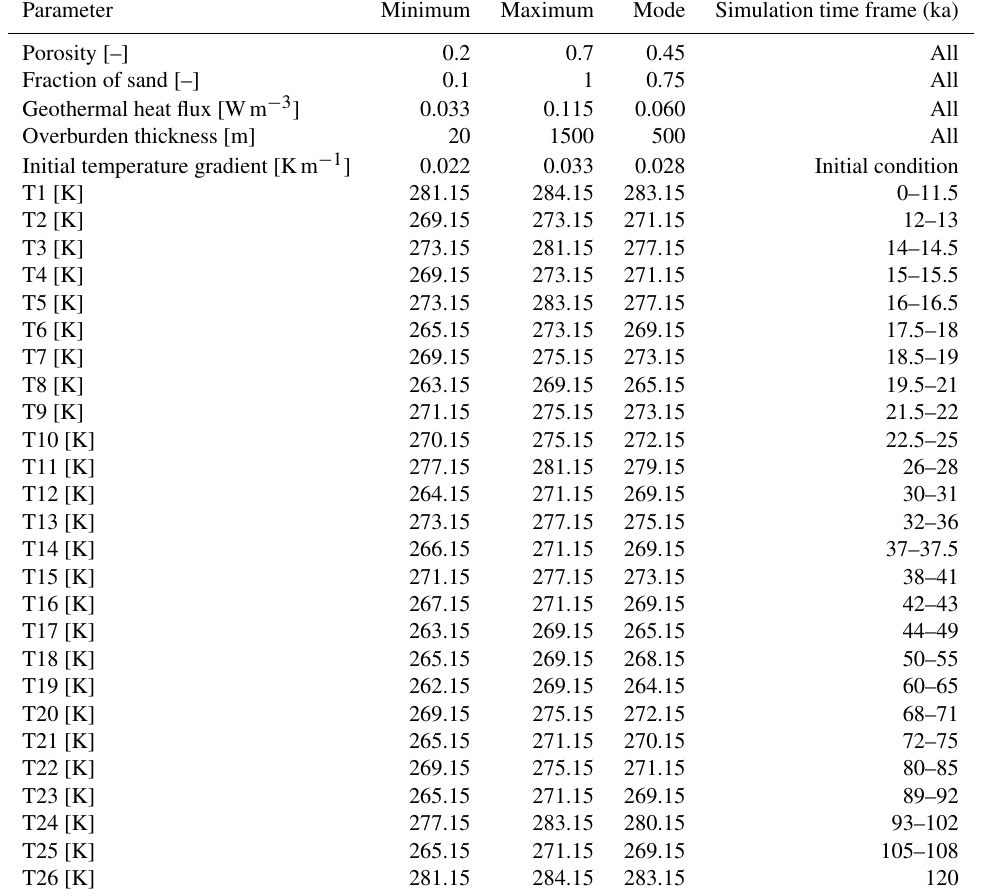
Table 2. Parameters and associated ranges used in the global UA and SA., T1 to T26, are used to control the magnitude of the various temperature plateaus during the Weichselian temperature cycle (Fig. 3), ranging from − 11 ◦ C for the lowest and + 11 ◦ C for the